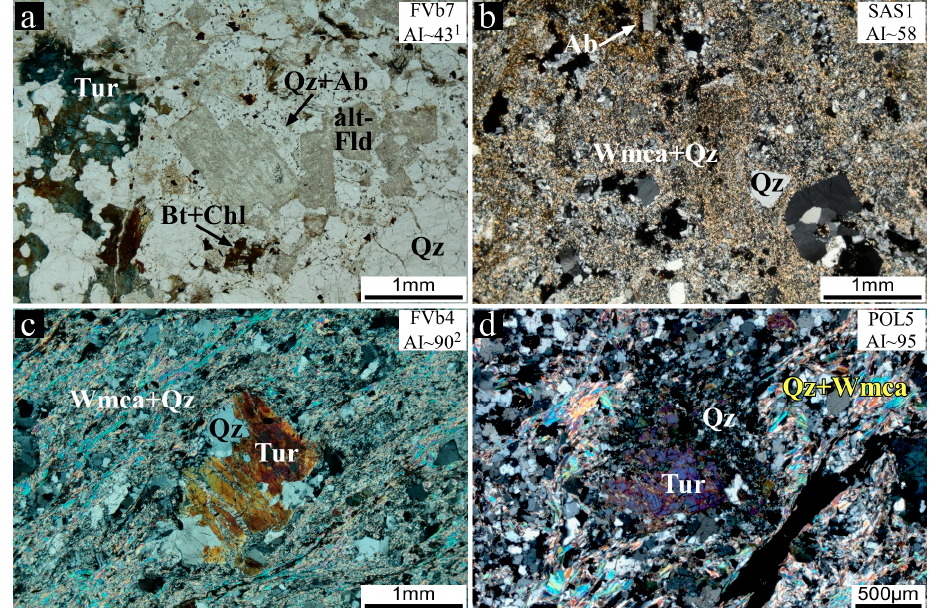
Figure 8. Petrographic features of the Fornovolasco Metarhyolite. ( a ) Porphyritic texture, showing phenocrysts of quartz, altered feldspars (sericite), biotite (partially altered in chlorite), and tourmaline. ( b ) Quartz and feldspar phenocrysts in a recrystallized white mica + quartz matrix. ( c , d ) Tourmaline + quartz porphyroclasts wrapped by the Alpine schistosity highlighted by white mica crystal orientation. Mineral abbreviation: Ab, albite; alt-Fld, altered feldspar phenocryst; Bt, biotite; Chl, chlorite; Qz, quartz; Tur, tourmaline; Wmca, white mica.